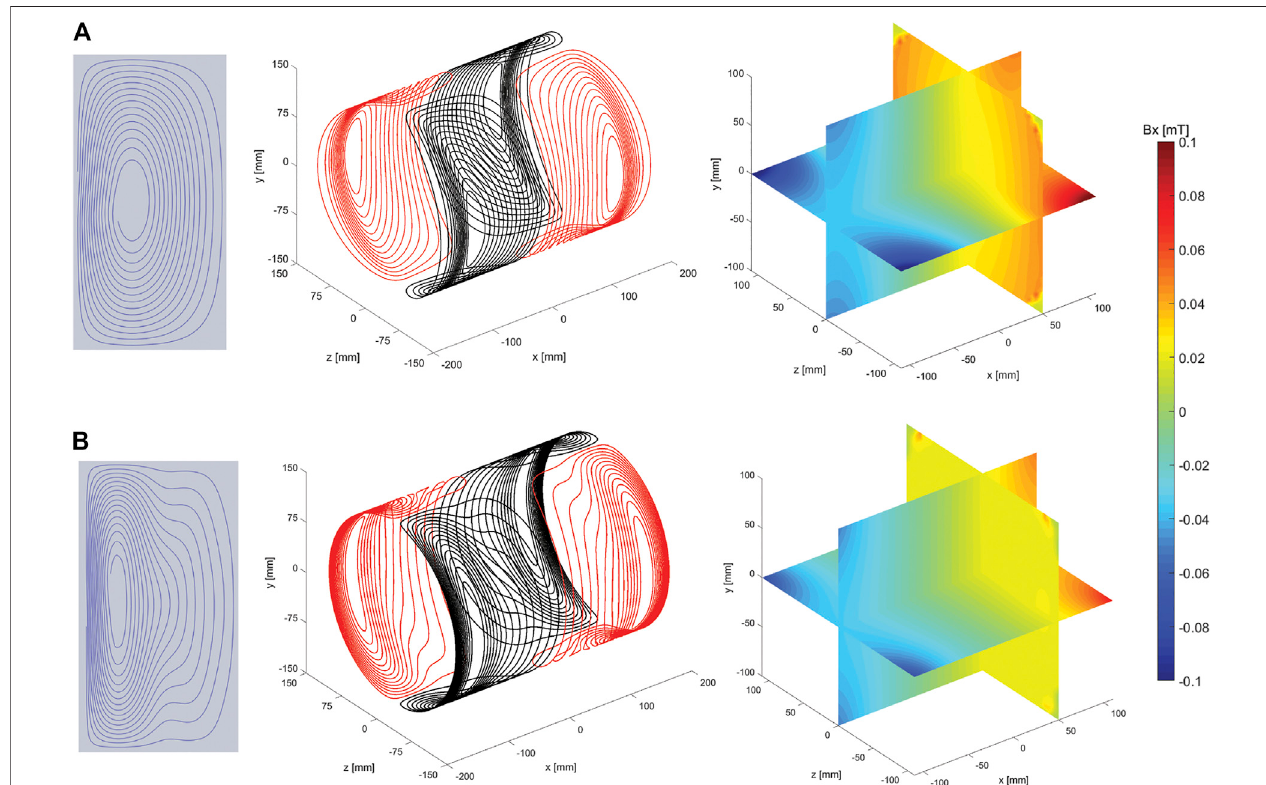
FIGURE1| Fromlefttoright: illustrations ofthewirepathsofasinglequadrant,illustration ofthecoils andthecorrespondingsimulatedmagnetic fi eldplots,forthe original (A) and new method (B) . Simulated magnetic fi elds created with 1 A driving current. The transverse plane slices are shown at x (cid:2) 50 mm.